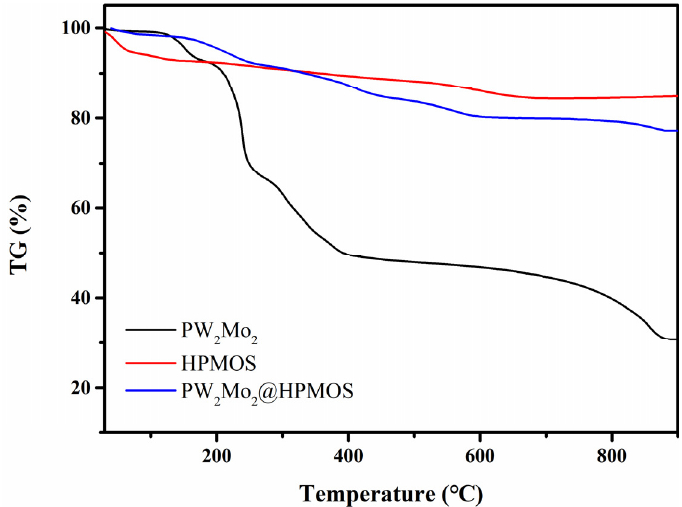
Figure 3. TG curves of PW 2 Mo 2 , HPMOS, and PW 2 Mo 2 @HPMOS.